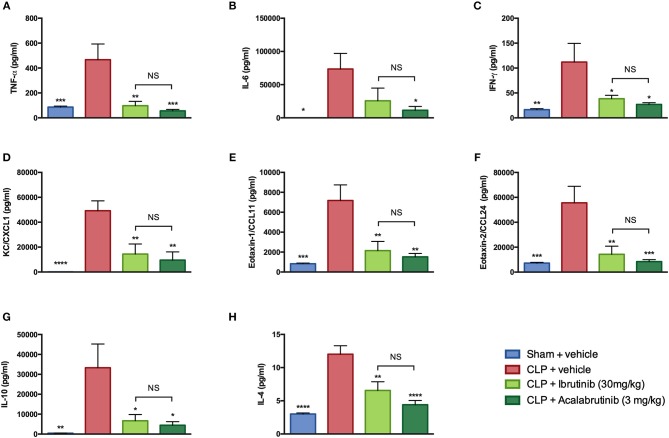
Systemic inflammation in CLP mice is reduced by ibrutinib or acalabrutinib. Mice were randomly assigned to undergo CLP or sham surgery. One hour later, mice were treated with ibrutinib (30 mg/kg i.v.), acalabrutinib (3 mg/kg i.v.), or vehicle (5% DMSO + 30% cyclodextrin i.v.). At 24 h after CLP, blood samples were collected, and the serum concentration of cytokines and chemokines were measured by a multiplex assay (n = 8 per group). (A) TNF-α serum concentration (pg/ml). (B) IL-6 serum concentration (pg/ml). (C) IFN-γ serum concentration (pg/ml). (D) KC/CXCL1 serum concentration (pg/ml). (E) Eotaxin-1/CCL11 serum concentration (pg/ml). (F) Eotaxin-2/CCL24 serum concentration (pg/ml). (G) IL-10 serum concentration (pg/ml). (H) IL-4 serum concentration (pg/ml). All data are expressed as mean ± SEM for n number of observations. Correlations coefficients were determined by Pearson's correlation with P-values based on two-tailed tests a value of ****P < 0.0001, ***P < 0.001, **P < 0.01, *P < 0.05 was considered to be statistically significant.